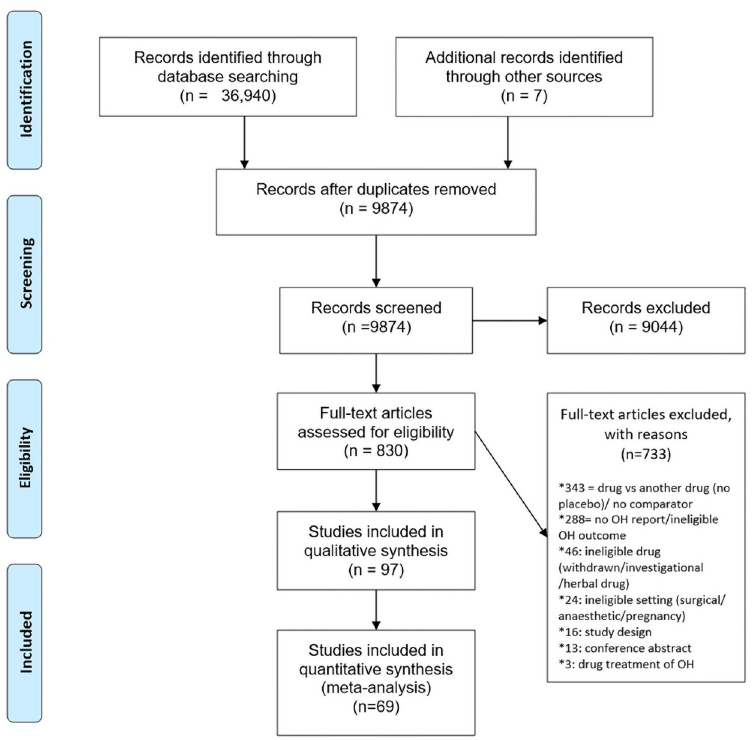
Fig 1. Diagram of study selection process for the systematic review and meta-analysis. OH, orthostatic hypotension.